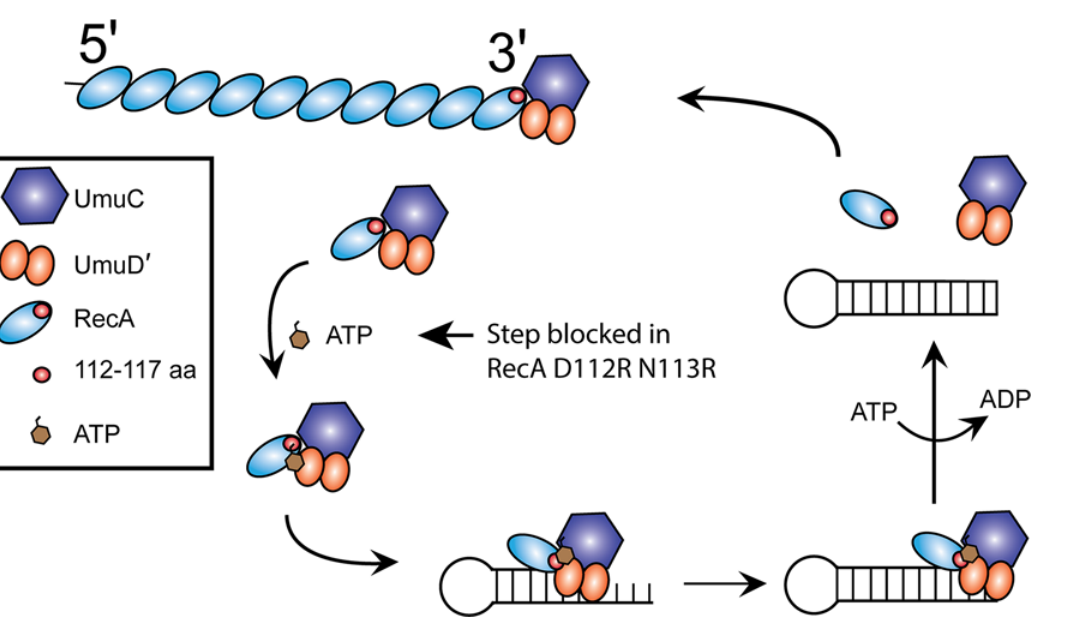
Fig 8. Model for pol V activation. A 3'-RecA monomer is transferred to pol V, to form pol V Mut which is unable to bind to primer-template DNA. The RecA 112 – 117 aa are close to UmuC in this initial interaction. ATP is bound to the complex to complete the activation, followed by binding to the primed template. We hypothesize that conformational changes alter the interaction between the RecA subunit and the UmuD 0 2 C subunits at successive stages of the reaction, and may make transient contacts with UmuD'. Pol V Mut will synthesize on the template, and can only dissociate from the primer-template DNA upon ATP hydrolysis. By exchanging the RecA subunit in the inactive complex for a new subunit obtained from RecA * , this released pol V can then be reactivated for another round of synthesis if ssDNA and RecA * are still